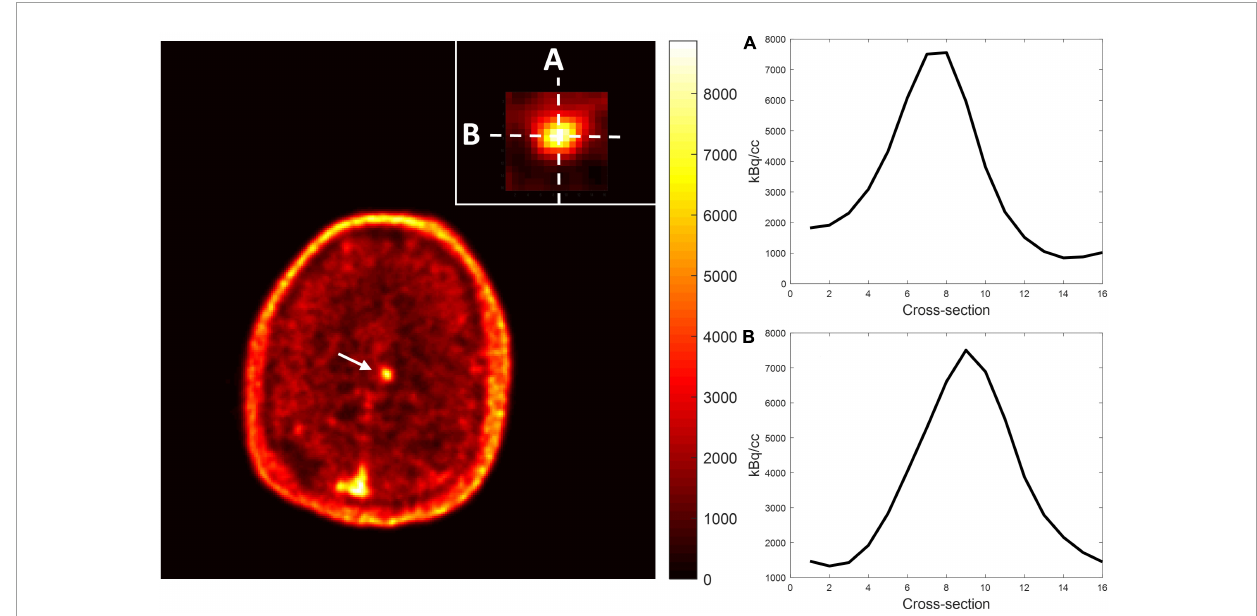
FIGURE3 Representative image contrast of flutriciclamide PET across the CCM lesion. Display vertical (A) and horizontal (B) cross-sections of CCM and nearby brain tissue areas.